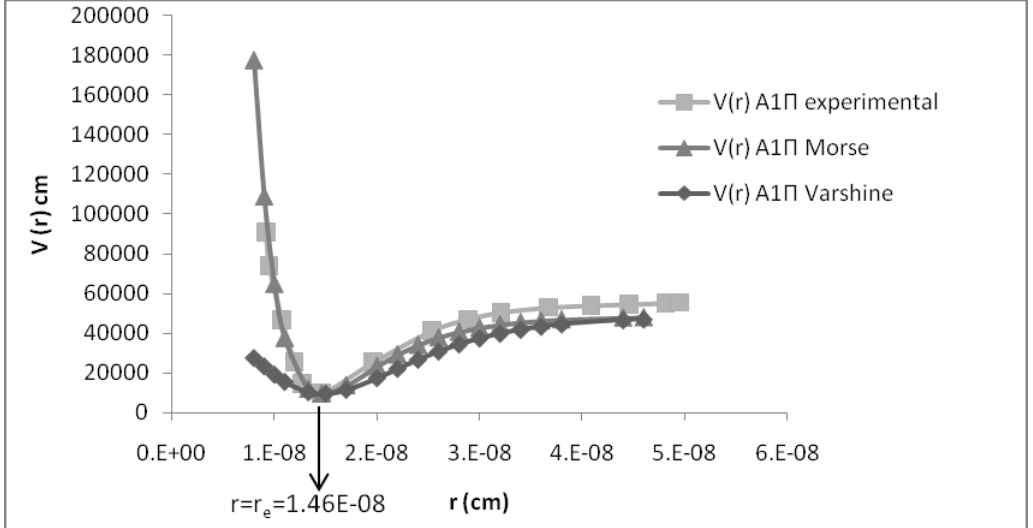
Fig.2: Theoretical potential calculated by Morse and Varshine function compare with the experimental curves for exited state A 1 Π.